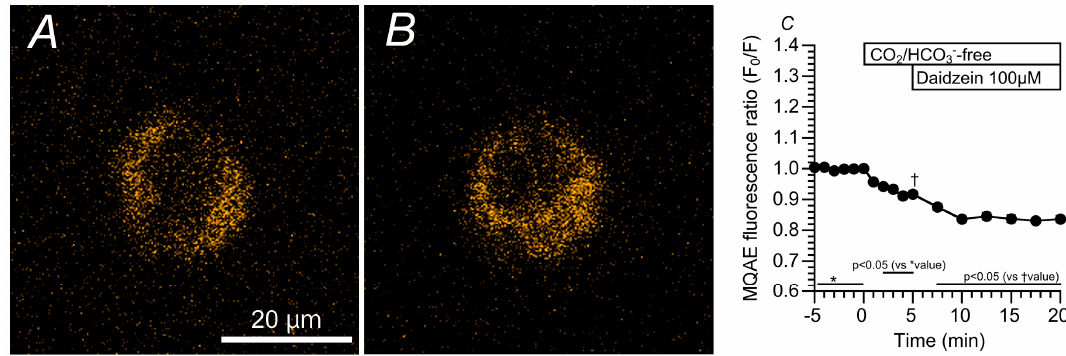
Figure 3. Changes in [Cl − ] i stimulated by daidzein. Prior to daidzein (100 µ M) stimulation, cHNECs were first perfused with CO 2 /HCO 3 − -containing control solution for five min, and then with CO 2 /HCO 3 − -free control solution for a further five min. ( A ) The MQAE ( N -ethoxycarbonylmethyl-6-methoxyquinolinium bromide, a Cl − sensitive fluorescent dye) fluorescent image of a cHNEC just before daidzein stimulation. ( B ) The MQAE fluorescent image of a cHNEC 15 min after stimulation with daidzein (100 µ M). The daidzein stimulation potentiated the intensity of MQAE fluorescence, indicating that daidzein stimulates a decrease in [Cl − ] i . ( C ) Changes in the MQAE fluorescence ratio (F 0 /F). The switch to the CO 2 /HCO 3 − -free control solution decreased F 0 /F (F 0 /F five min after the switch = 0.92 ± 0.01, n = 6). Further stimulation with daidzein decreased F 0 /F (F 0 /F 10 min after the stimulation = 0.83 ± 0.01, n = 6).